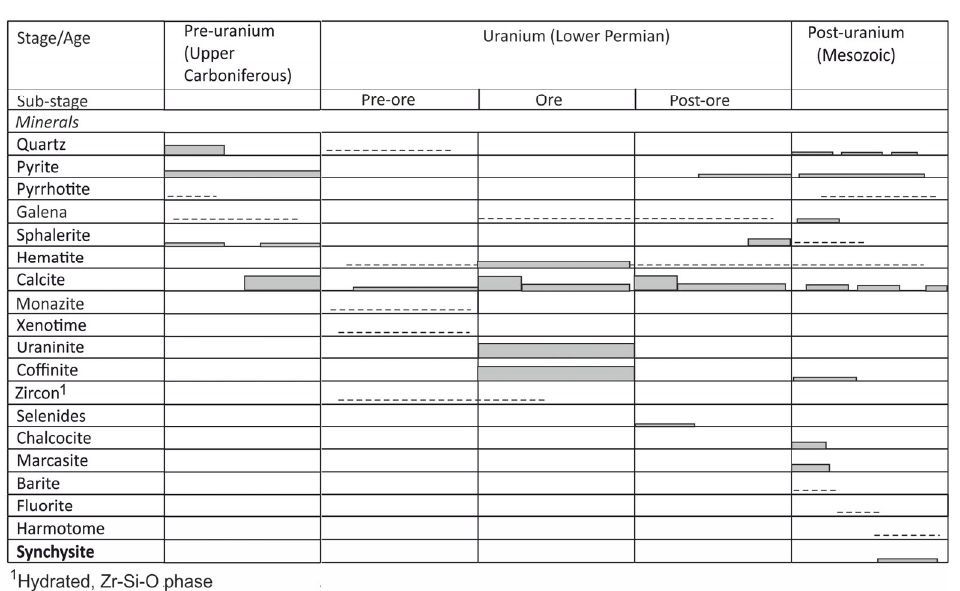
Figure 2. Stages, substages and types of late Variscan and post-Variscan hydrothermal mineralization in the Rožná uranium deposit. Simplified following [21,24].